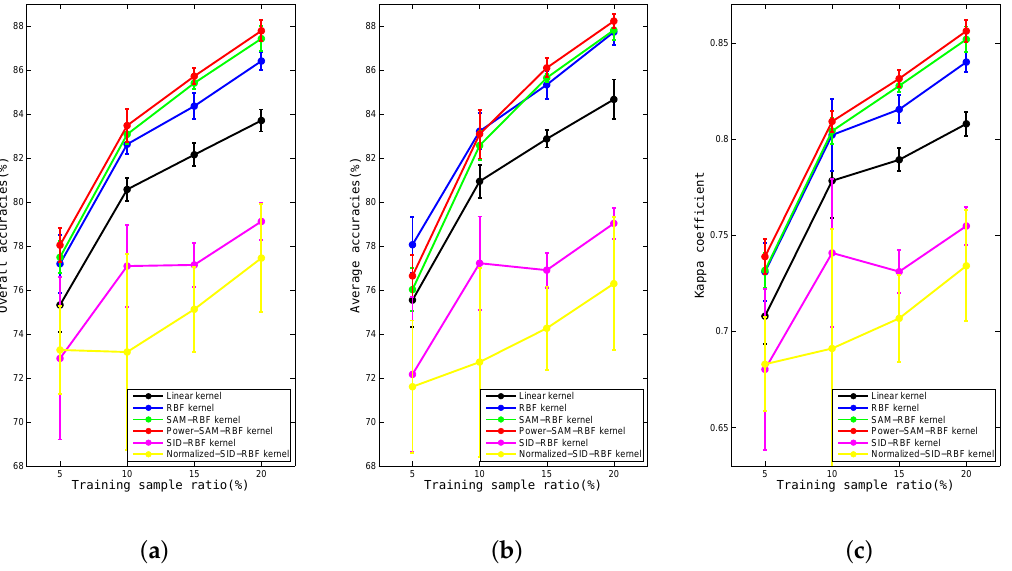
Figure 8. Curves of the ( a ) OA, ( b ) AA, and ( c ) kappa coefficient for the Linear, RBF, SAM-RBF, Power-SAM-RBF, SID-RBF, and Normalized-SID-RBF kernels with proportions of training data of 5%, 10%, 15%, and 20% for the Indian Pines